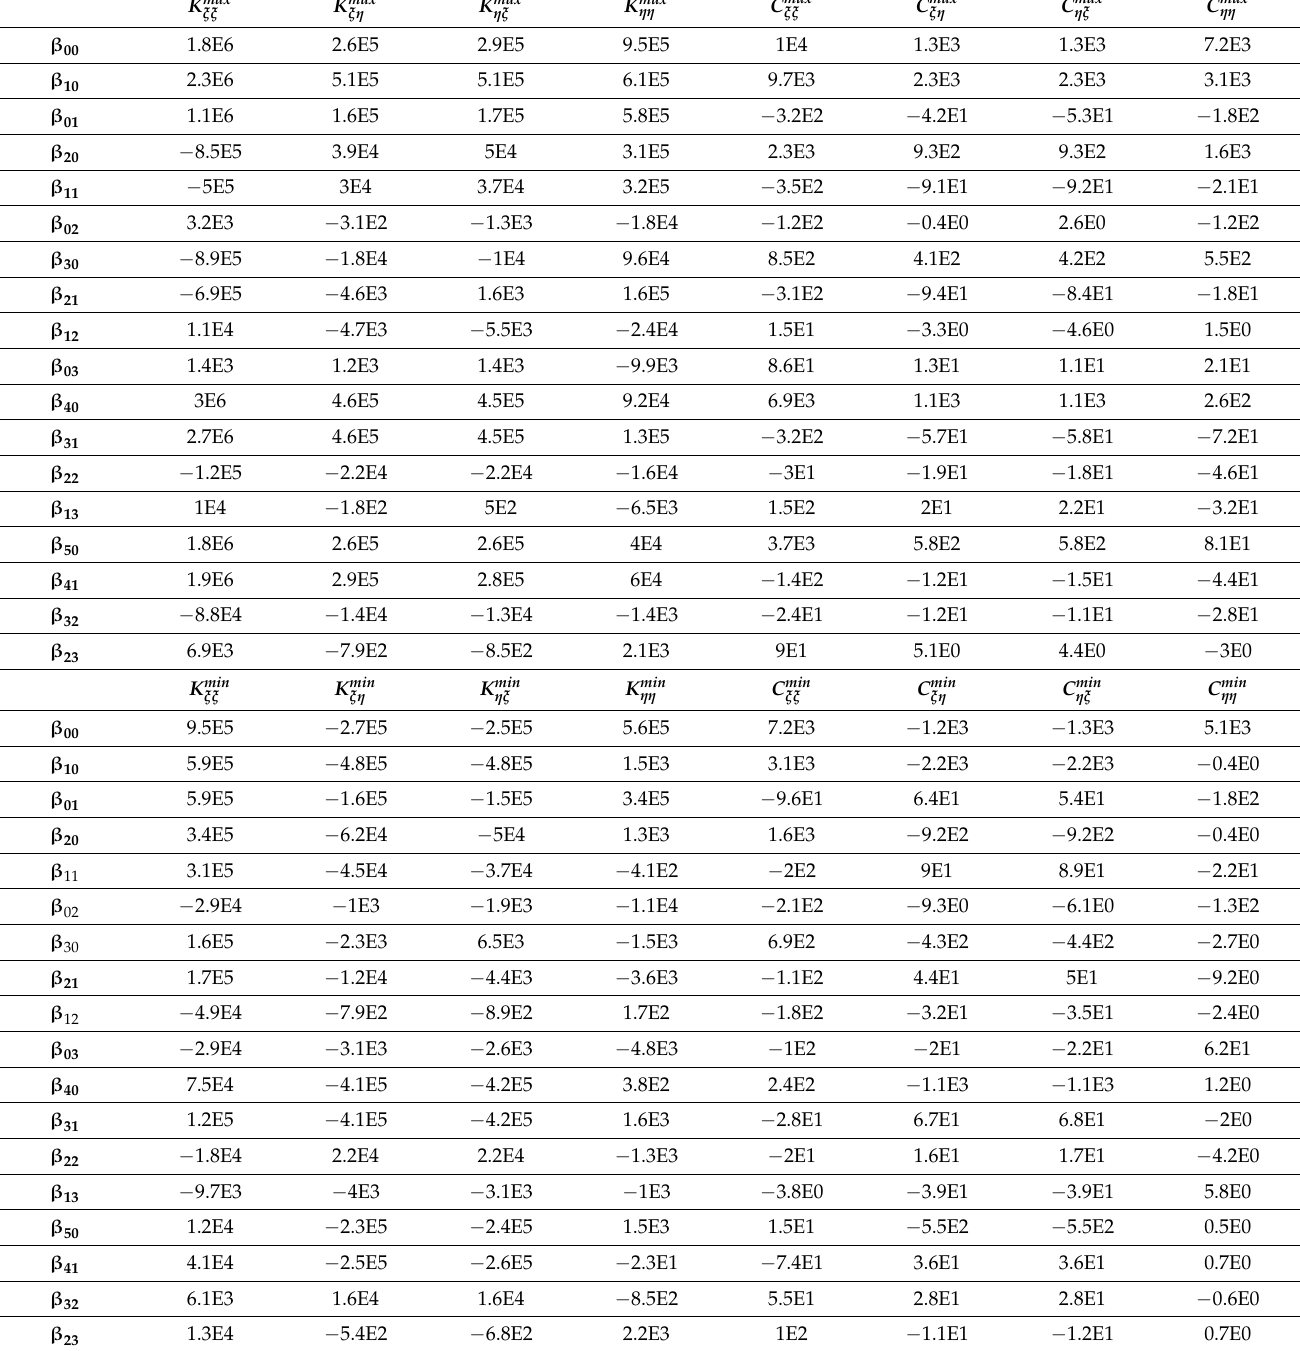
Table A2. Calculated coefficients of the two-dimensional polynomial equation ( poly53 ) as a function of centered and scaled relative eccentricity ( ε ) and rotor speed ( Ω ). The relative eccentricity ( ε ) is normalized by mean and standard deviation of 0.4011 and 0.2589, respectively. The rotor speed ( Ω ) is normalized by mean and standard deviation of 1292 and 803.5,